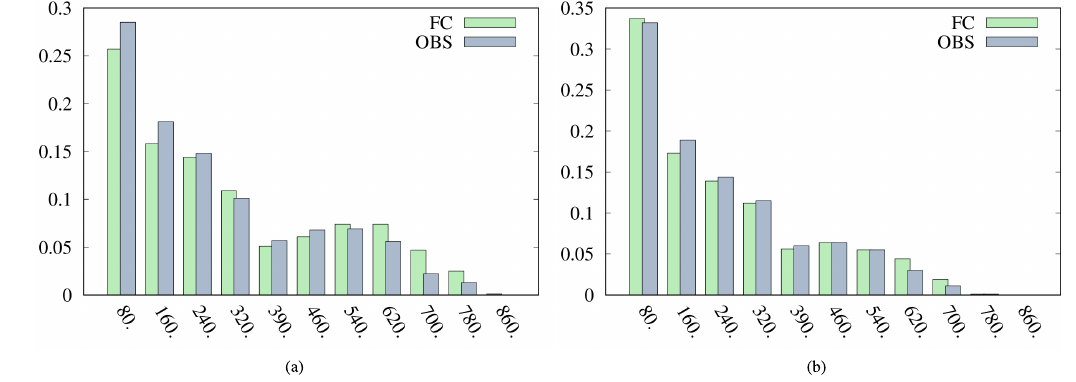
Figure 5. Observed (grey) and forecast (green) SWDS distribution using all available data between April 2006 and March 2016: (a) Jokioinen (b) Sodankylä. Units on x -axis: Wm − 2 , on y -axis: relative frequency [0,1].